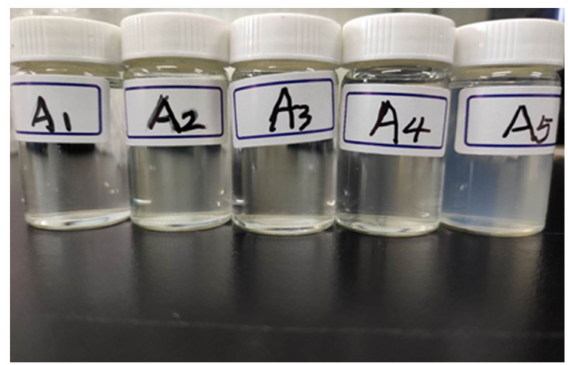
Figure 10. SiO 2 / Al 2 O 3 composite-hardening sol with di ff erent proportion.